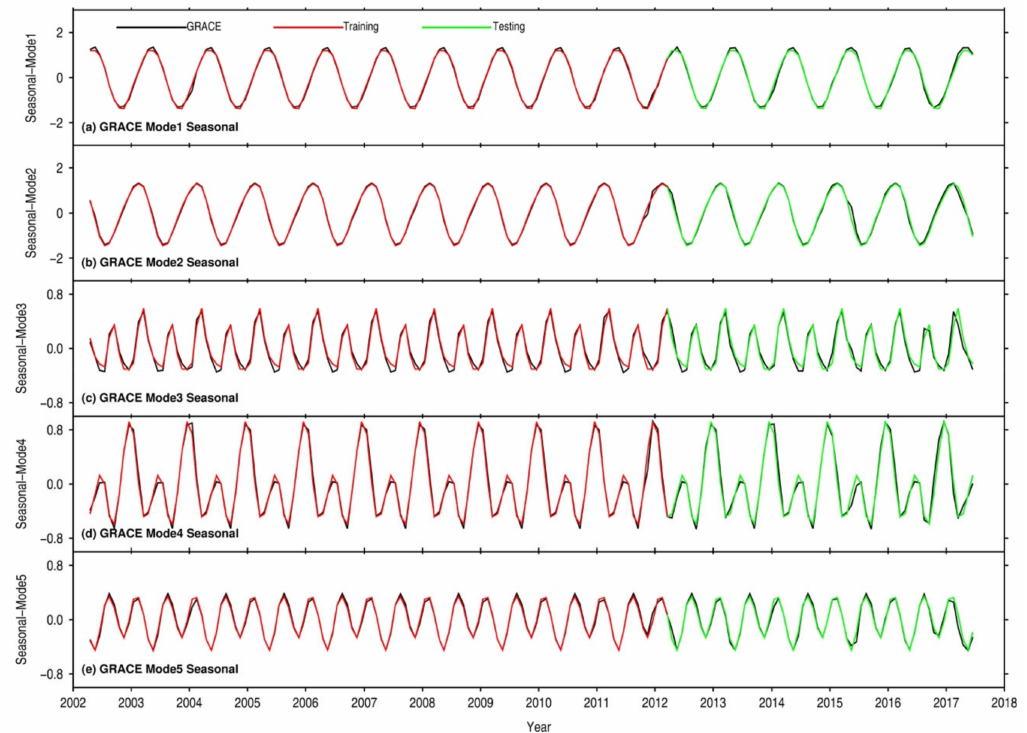
Figure A1. Seasonal components of the five leading GRACE temporal modes (black lines) relative to the model outputs in the training (red lines) and testing periods (green